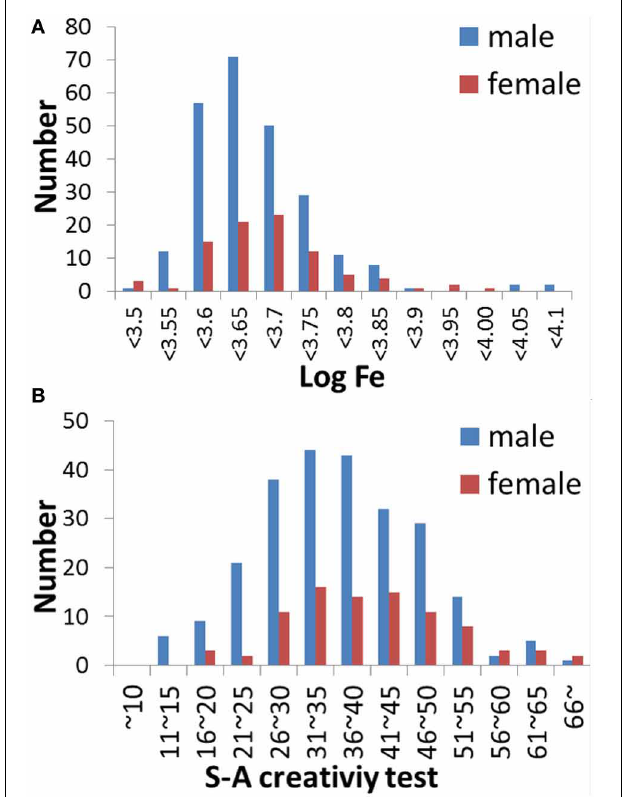
FIGURE 1 | Histograms of the variables. (A) A histogram showing the logarithms of hair iron levels for male and female subjects. (B) A histogram showing S-A creativity test scores for male and female subjects.